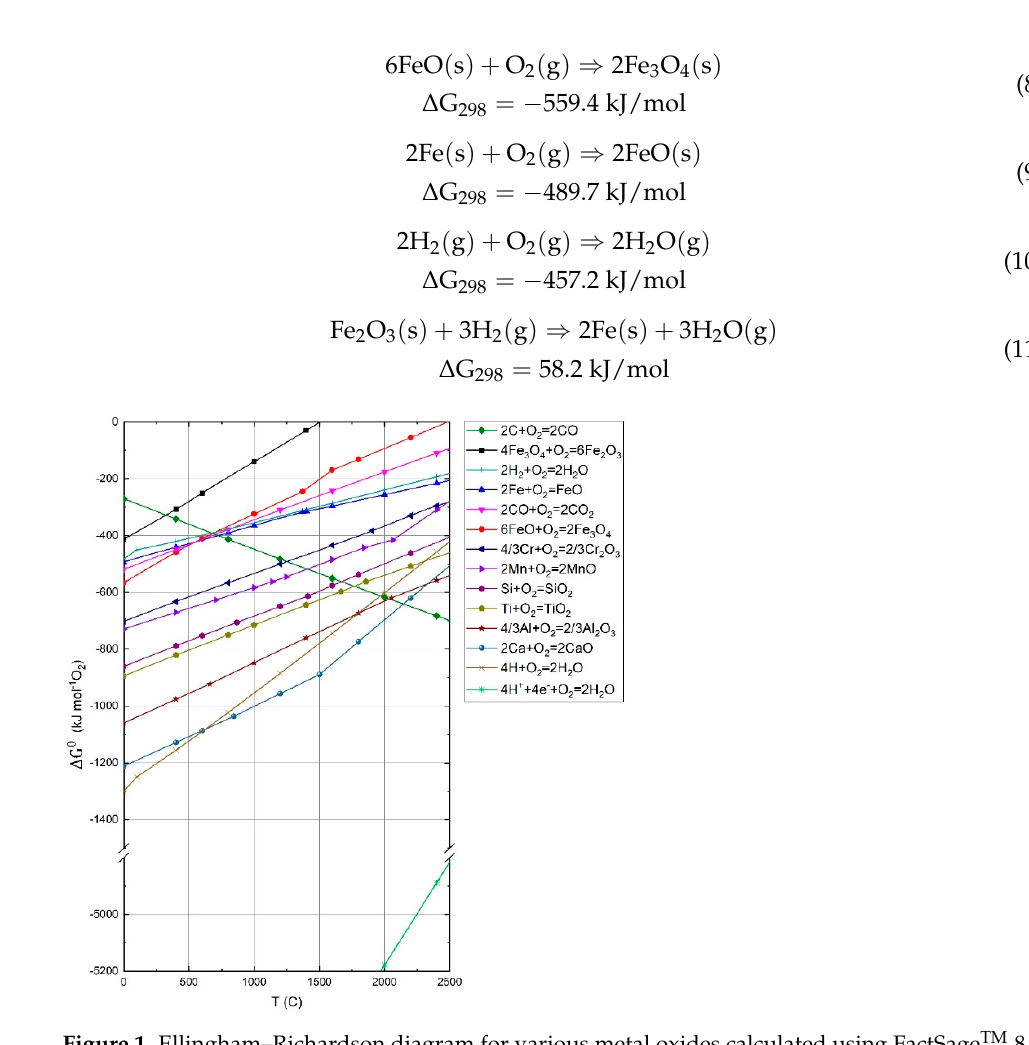
Figure 1. Ellingham–Richardson diagram for various metal oxides calculated using FactSage TM 8.0, Database FToxide (2019) [5].